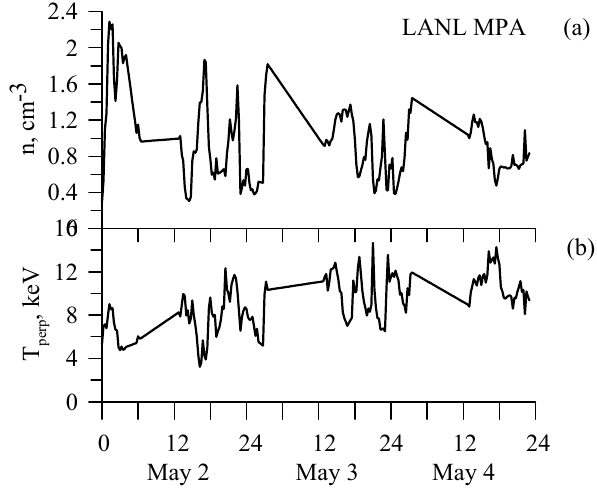
Fig. 6. ( a ) Plasma sheet number density and ( b ) averaged perpen- dicular temperature used as boundary conditions for the modeled period of 2–4 May 1998 obtained from the MPA instrument data on board the Los Alamos (LANL) geosynchronous orbit